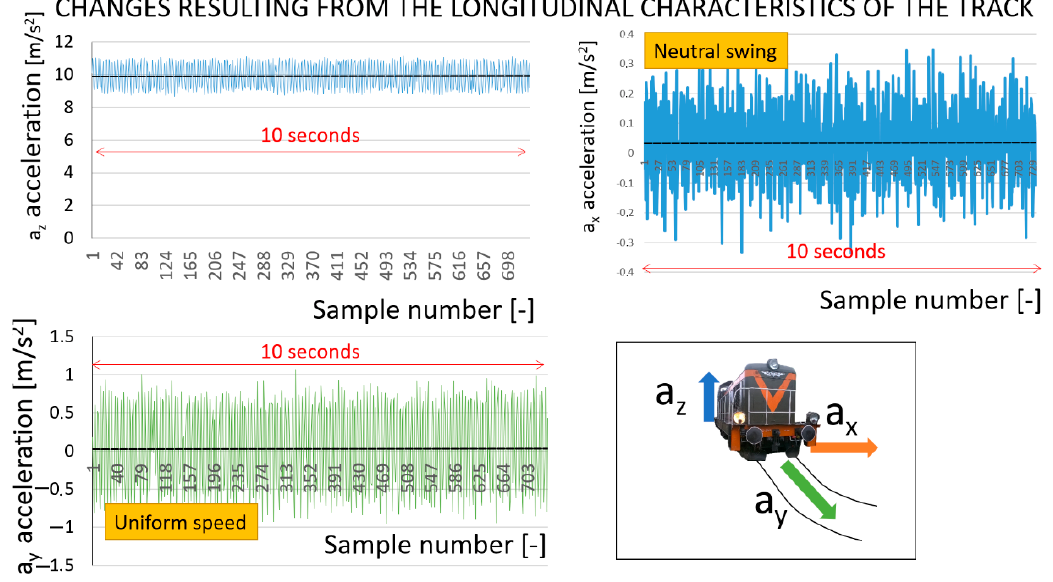
Figure 6. Visualization of example data from the output file containing linear